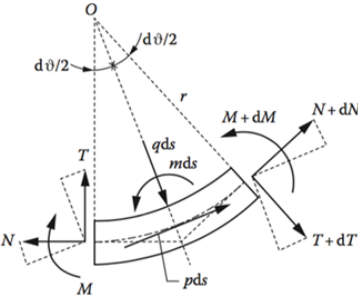
Figure 5: Beam with curvilinear axis